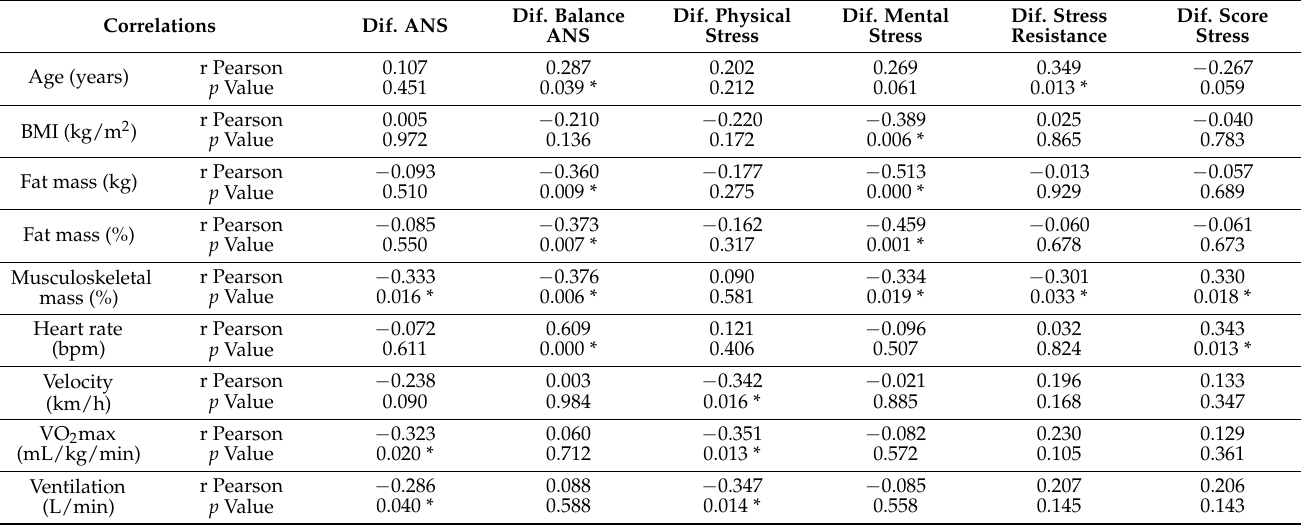
Table 7. Correlations between ST before—ST after differences and independent